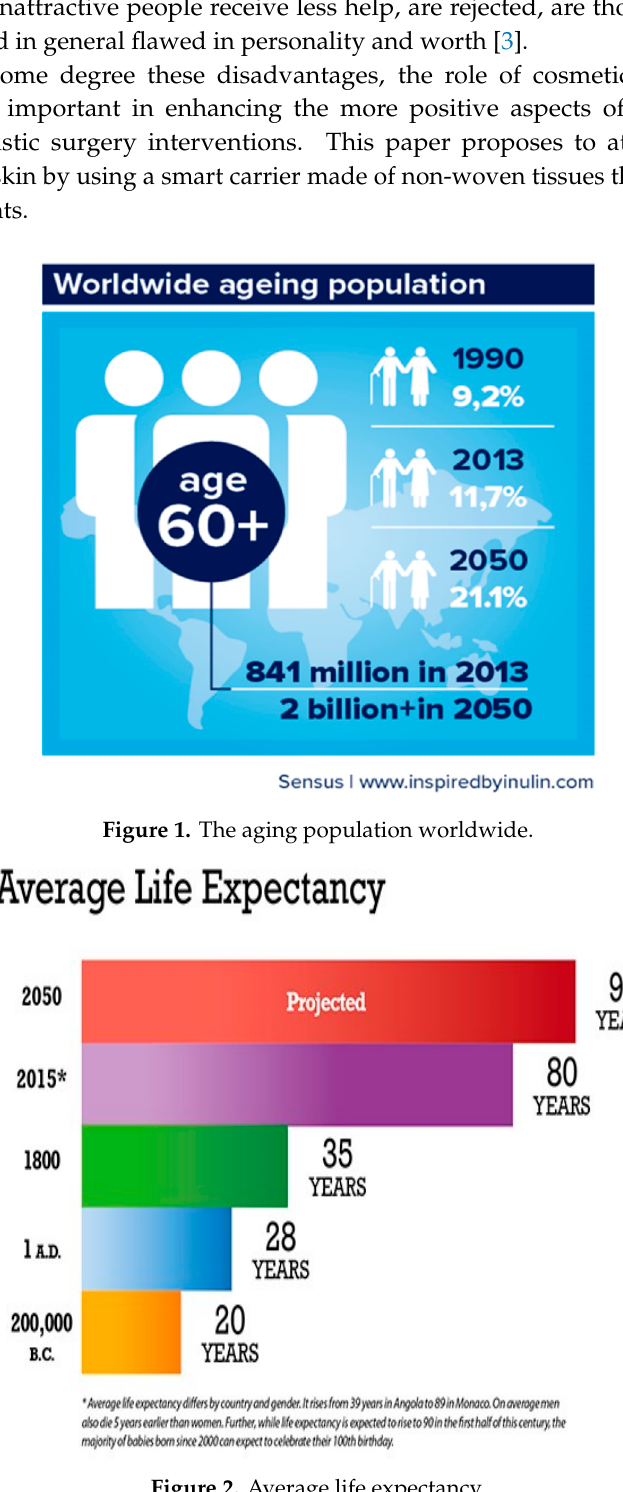
Figure 2. Average life expectancy.